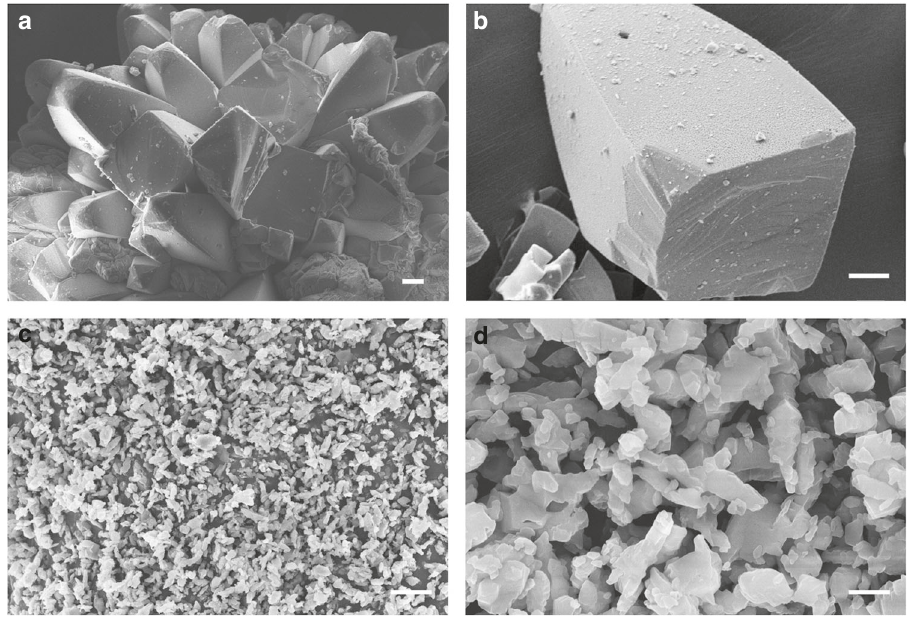
Fig. 3 Scanning electron microscope images of ICM-101. a , b ICM-101 crystals grown from DMSO. The scale bars in a and b represent 20 μ m. c , d The as- synthesized powder sample. The scale bar in c represents 10 μ m and the scale bar in d represents 2 μ